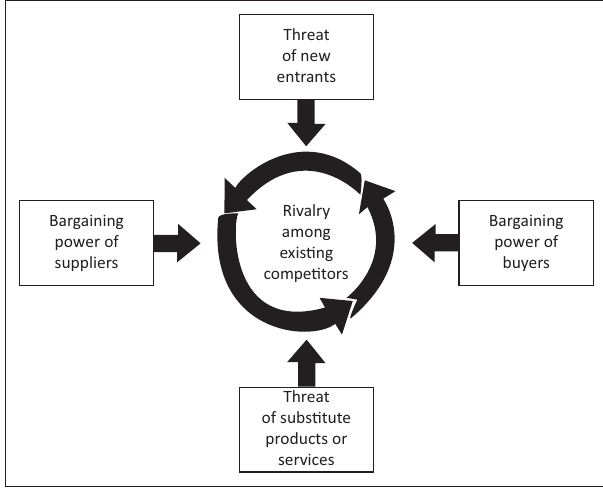
FIGURE 1: The five forces that shape industry